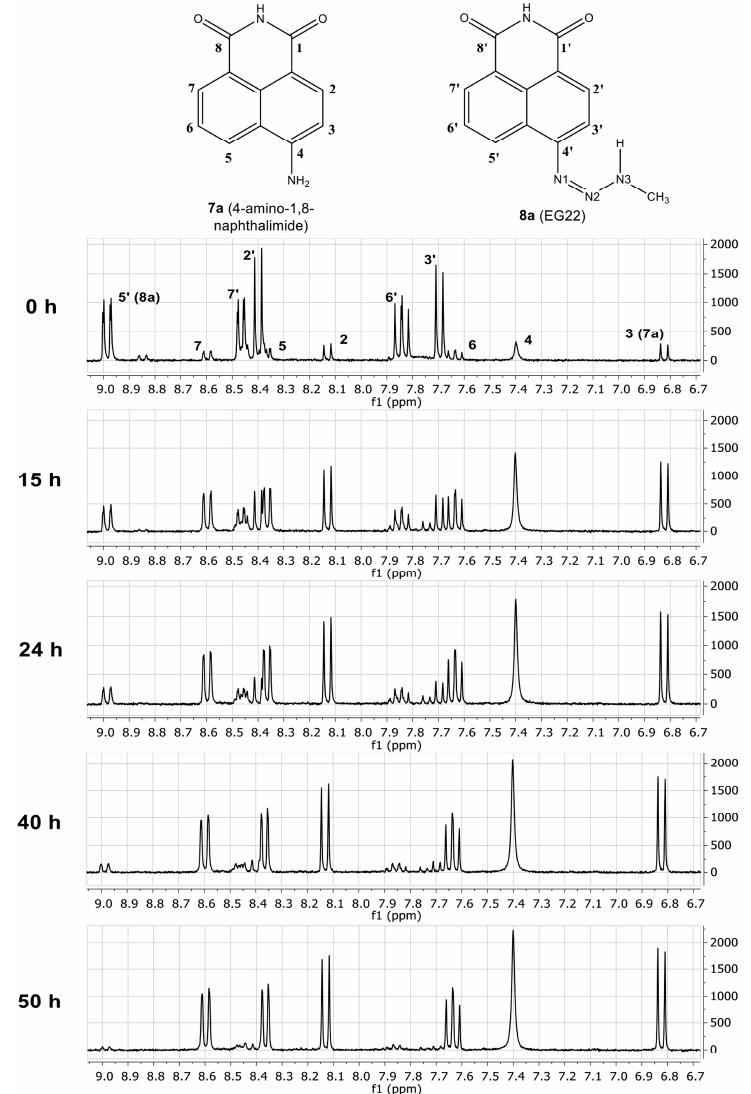
Figure 1. 1 H-NMR spectra of EG22 ( 8a ) showing slow conversion to ANI ( 7a ) (0–50 h) in non-dried DMSO- d 6 .